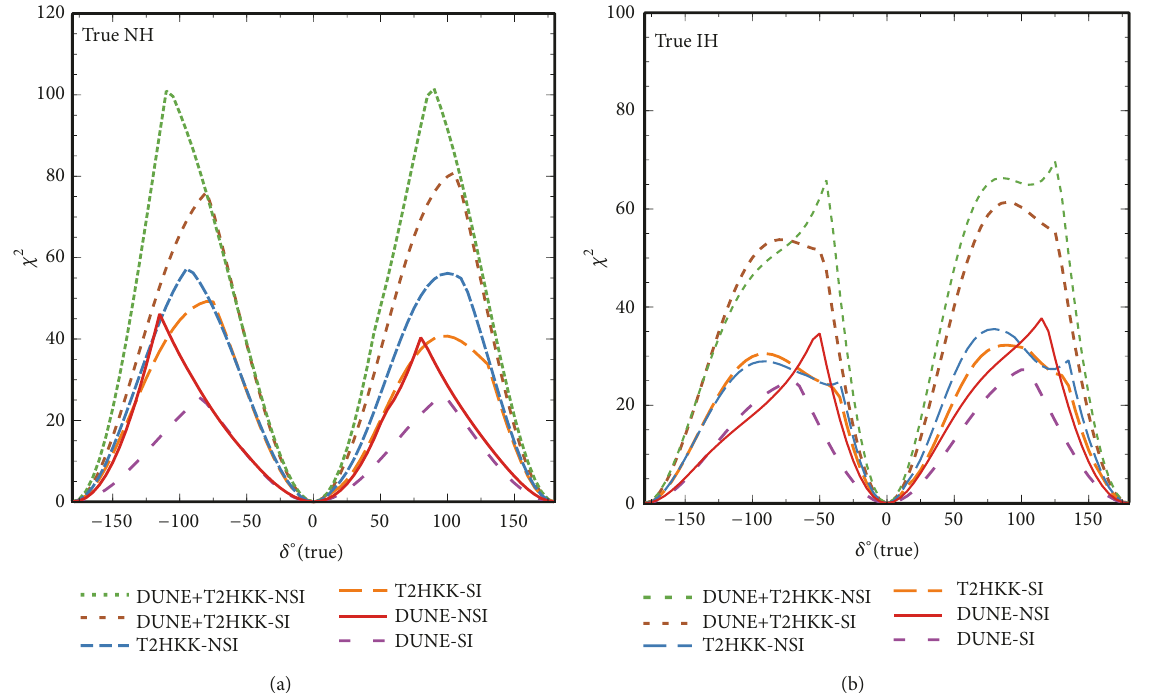
Figure 7: Sensitivity plots for 𝐶𝑃 violation with true NH (left) and true IH (right) assuming NSI parameters 𝜖 푒휇 = 0.04 and 𝛿 푒휇 (𝑡𝑟𝑢𝑒) = 𝜋/2 .